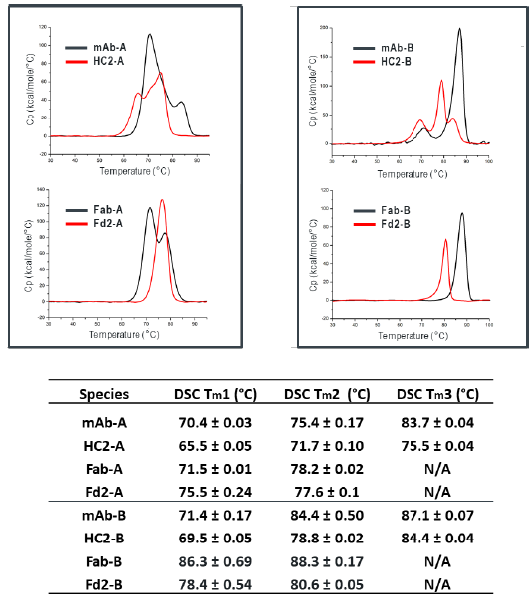
Figure 3. DSC profiles and tabulated T m data for mAb, HC2, Fab, and Fd2 constructs for both A and B molecules. DSC profiles in the upper right box are for the A forms; upper left for the B forms. Below are the tabulated T m values for each species.